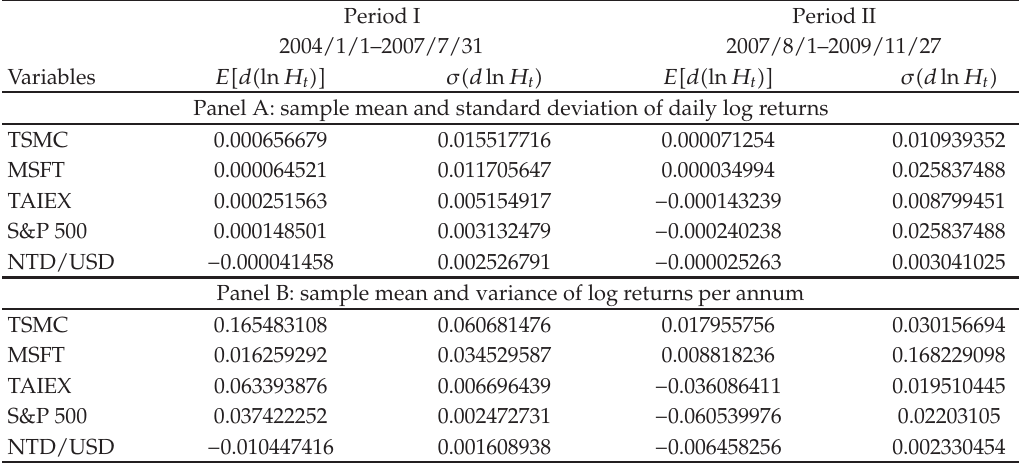
Table 1: Sample mean and standard deviation of daily log returns of securities and exchange rates in various periods.